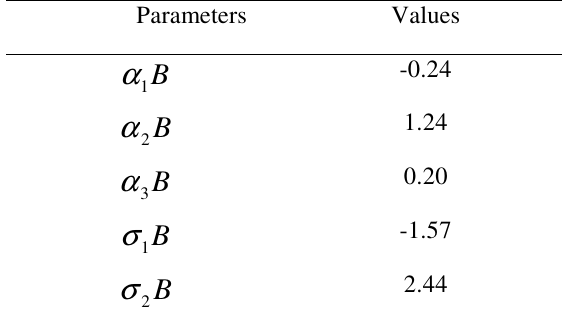
Table 1 Values of second-order potential parameters (in G Pa) of LiNbO